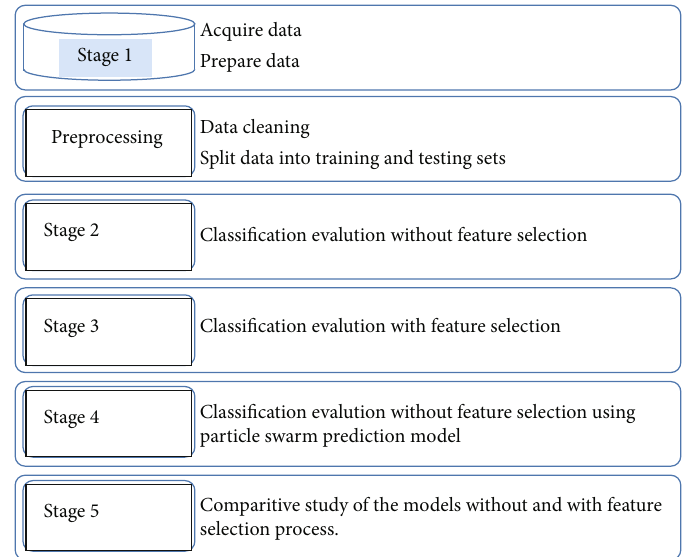
Figure 2: The proposed